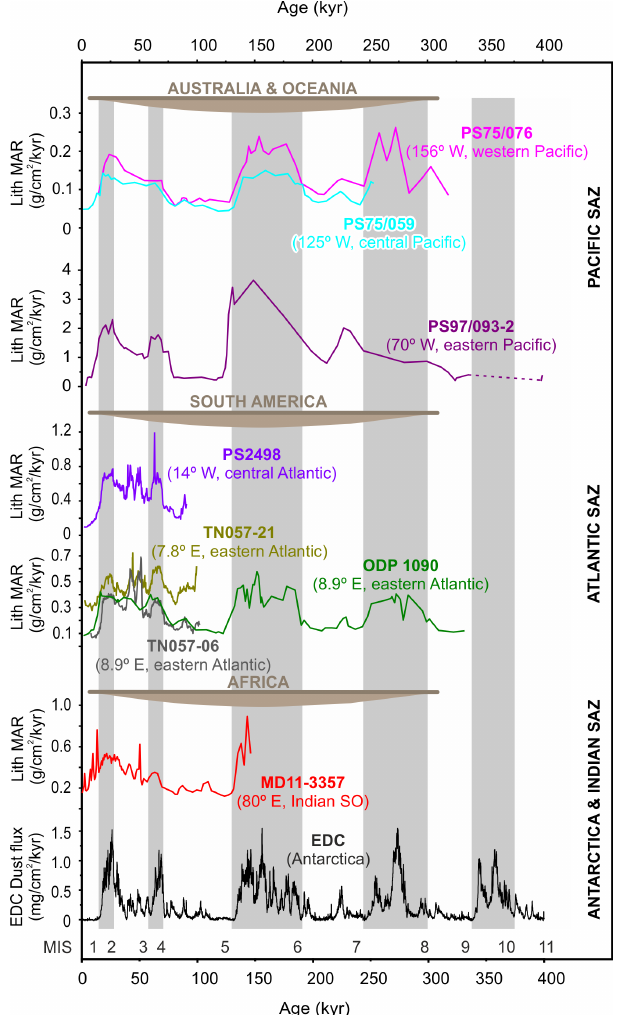
Figure 5. Changes in 230 Th-normalized lithogenic MARs in the subantarctic Southern Ocean (see Fig. 1 for location of sites dis- cussed). From top to bottom: Cores PS75/076 and PS75/059 (Lamy et al., 2014); Core PS97/093-2 (this study); Core PS2498 (Ander- son et al., 2014); Cores TN057-21 and TN056-06 (Anderson et al., 2014) and ODP1090 (Martínez-Garcia et al., 2009); Core MD11- 3357 (Thöle et al., 2019); and dust MAR in the EPICA Dome C ice core (Lambert et al., 2008). Numbers in the lower part of the fig- ure indicate Marine Isotope Stage (MIS); grey bars denote glacial stages. Continental masses are located in their relative longitudi- nal position to the marine sediment cores and represent the primary source of terrigenous inputs to the Subantarctic